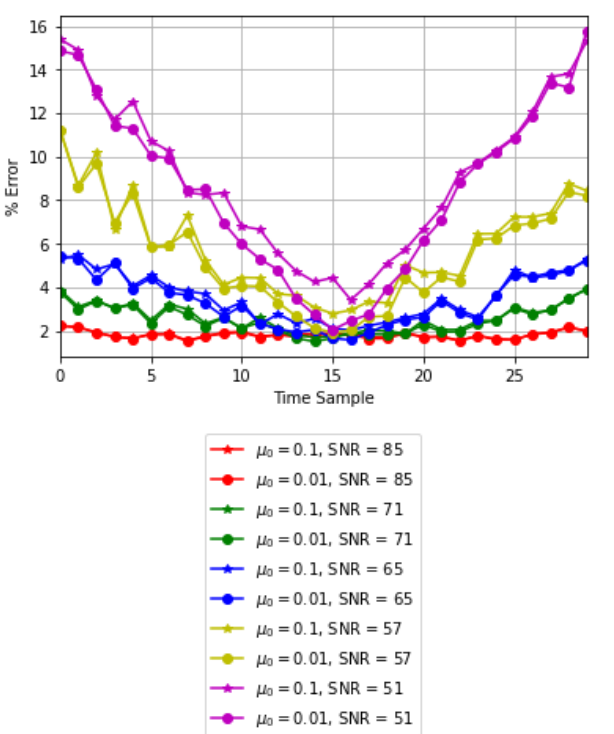
Figure 8. Summary of the % error for an image with added Gaussian source noise for a single-lensed microlensing event with µ 0 = 0.1 and µ 0 = 0.01 for varying levels of Gaussian noise addition to the spatial region of interest.